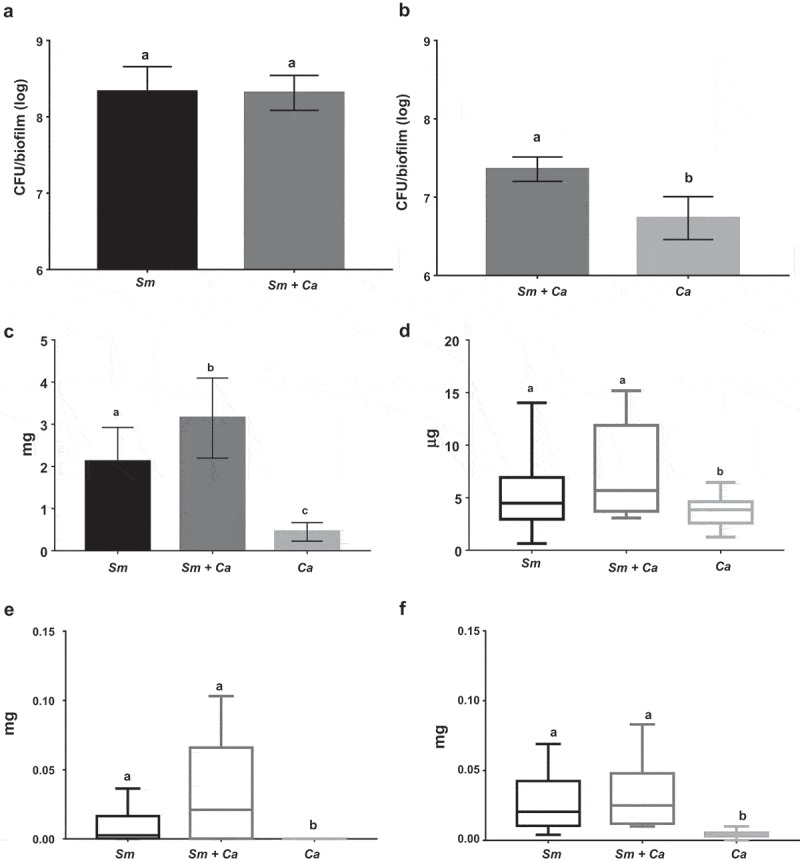
Quantification of viable microbial cell numbers, biomass and exopolysaccharides in the matrix of 43 h-old S. mutans and C. albicans in single- and dual-species biofilms. The S. mutans (A) and C. albicans (B) population are shown as average and standard deviation (n = 12). Graph C depicts the biofilms biomasses (insoluble dry-weight), as average and standard deviation (n = 12). Graph D shows protein data as median and interquartile range (n = 12). The exopolysaccharides in the matrix are water-soluble (E) and -insoluble (F) data as median and interquartile range. Similar letters indicate the absence of statistical difference per trait evaluated. Sm: S. mutans and Ca: C. albicans.